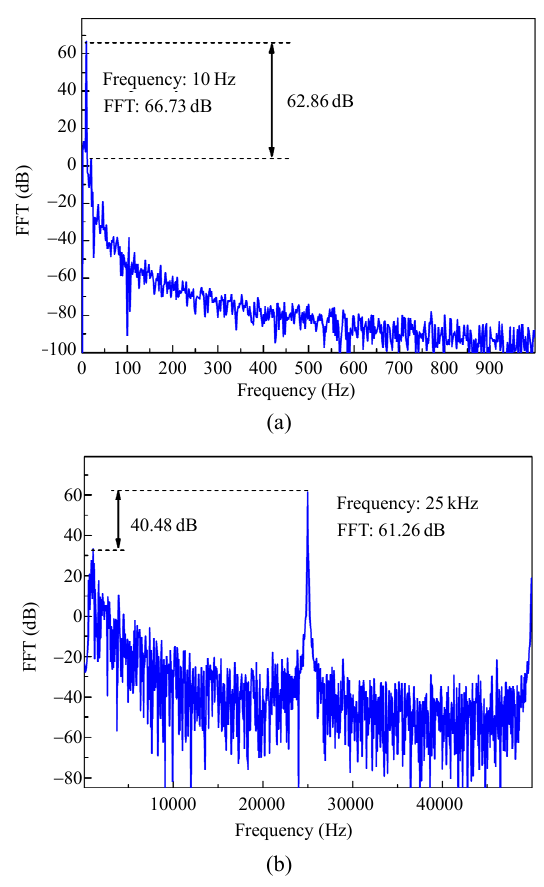
Fig. 14 Results of frequency response experiments: (a) minimum frequency response of the system for the driving frequency of 10 Hz and (b) maximum frequency response of the system for the driving frequency of 25